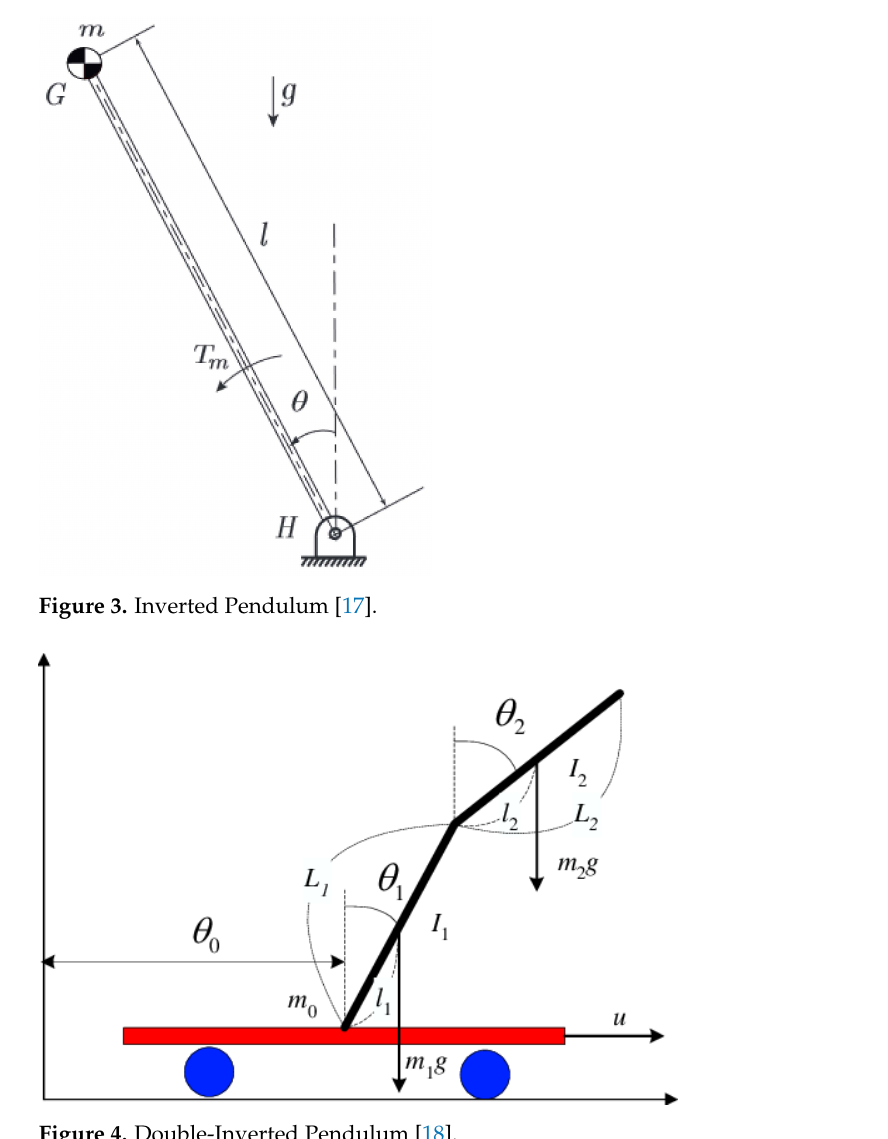
Figure 4. Double-Inverted Pendulum